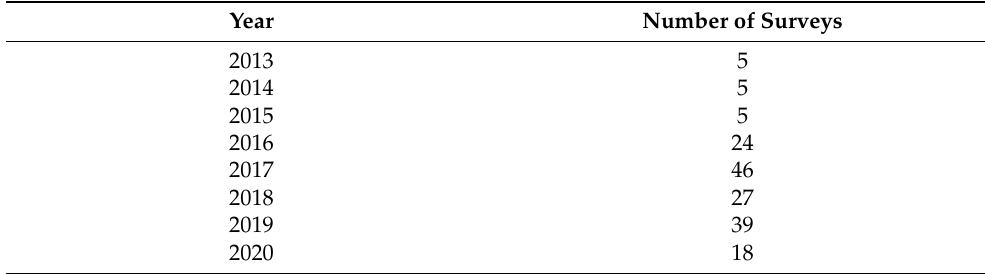
Table 8. Number of airborne LiDAR surveys flown over NEON sites across the